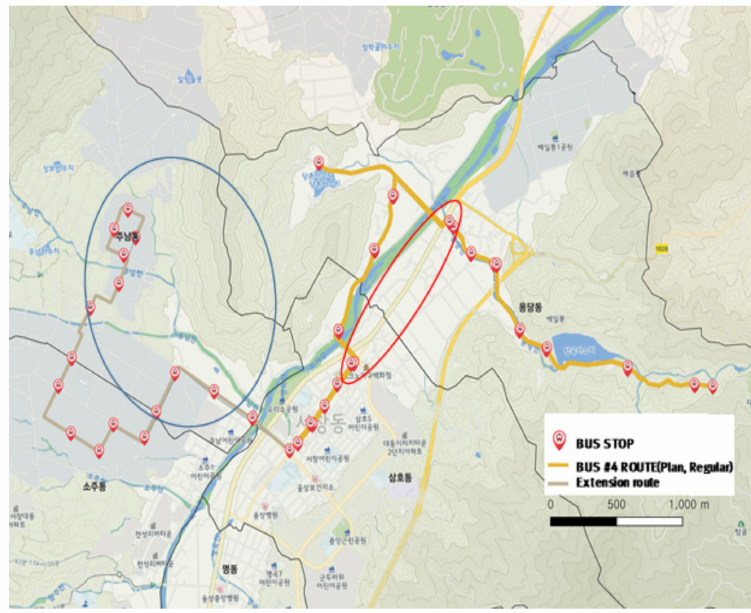
Figure 15. City-type bus No. 4